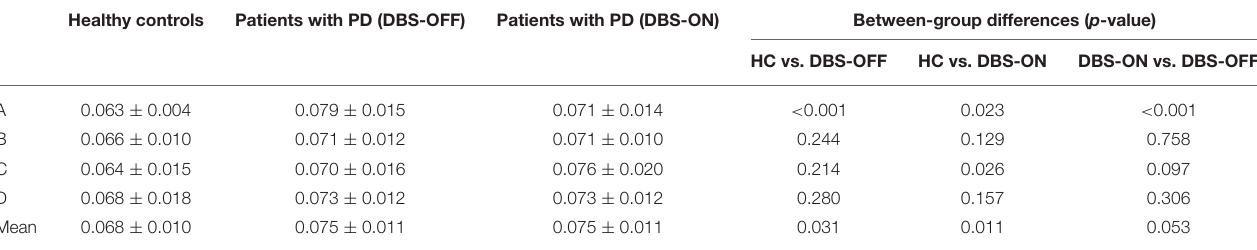
TABLE 1 | Duration of microstate classes A to D and mean of three groups, and results from the comparison between groups with an independent sample t -test and a paired sample t -test. Healthy controls Patients with PD (DBS-OFF) Patients with PD (DBS-ON) Between-group differences ( p -value) HC vs. DBS-OFF HC vs. DBS-ON DBS-ON vs.